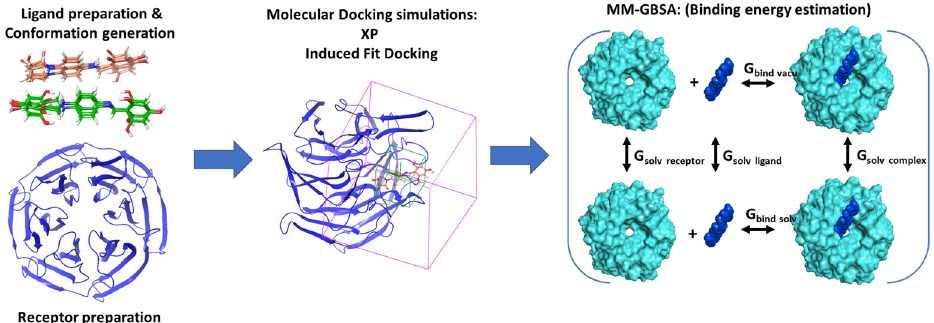
Figure 1. Designed workflow for in silico simulations of SH-29 and SK-119.